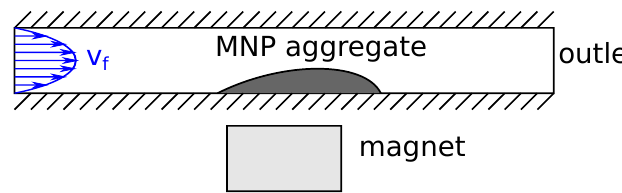
Figure 7. Sketch of the simulation of the microchannel. The fluid with the nanoparticles flows from the left to the right. The fluid has a parabolic velocity profile. The neodymium magnet is positioned under the center part of the magnet. As the particles arrive in the field of the magnet from the left, they start to aggregate at the bottom